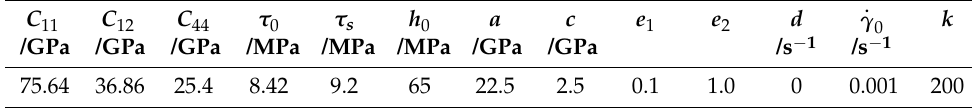
Table 2. The material parameters of single crystal